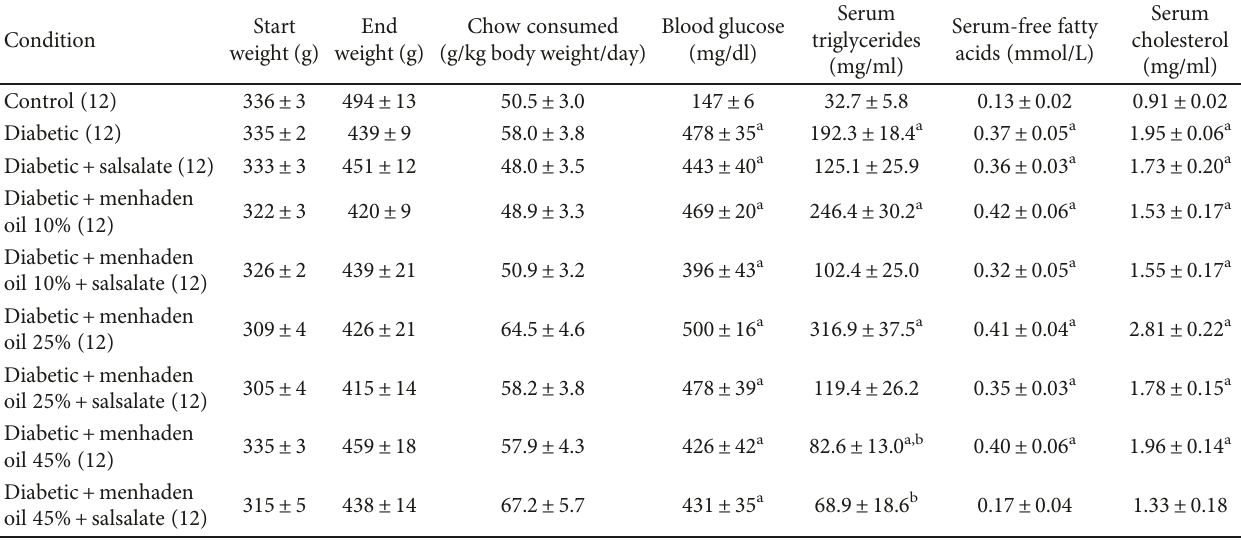
Table 1: E ff ect of menhaden oil with or without salsalate on weight, chow consumed, serum triglycerides, free fatty acids, and cholesterol in type 2 diabetic Sprague Dawley